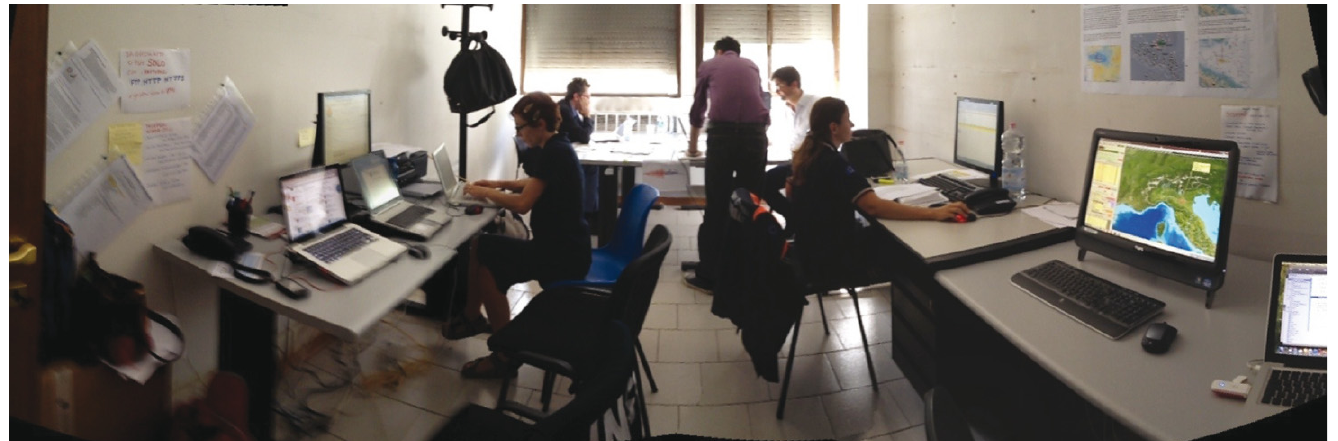
Figure 4. Photograph of the COES room in